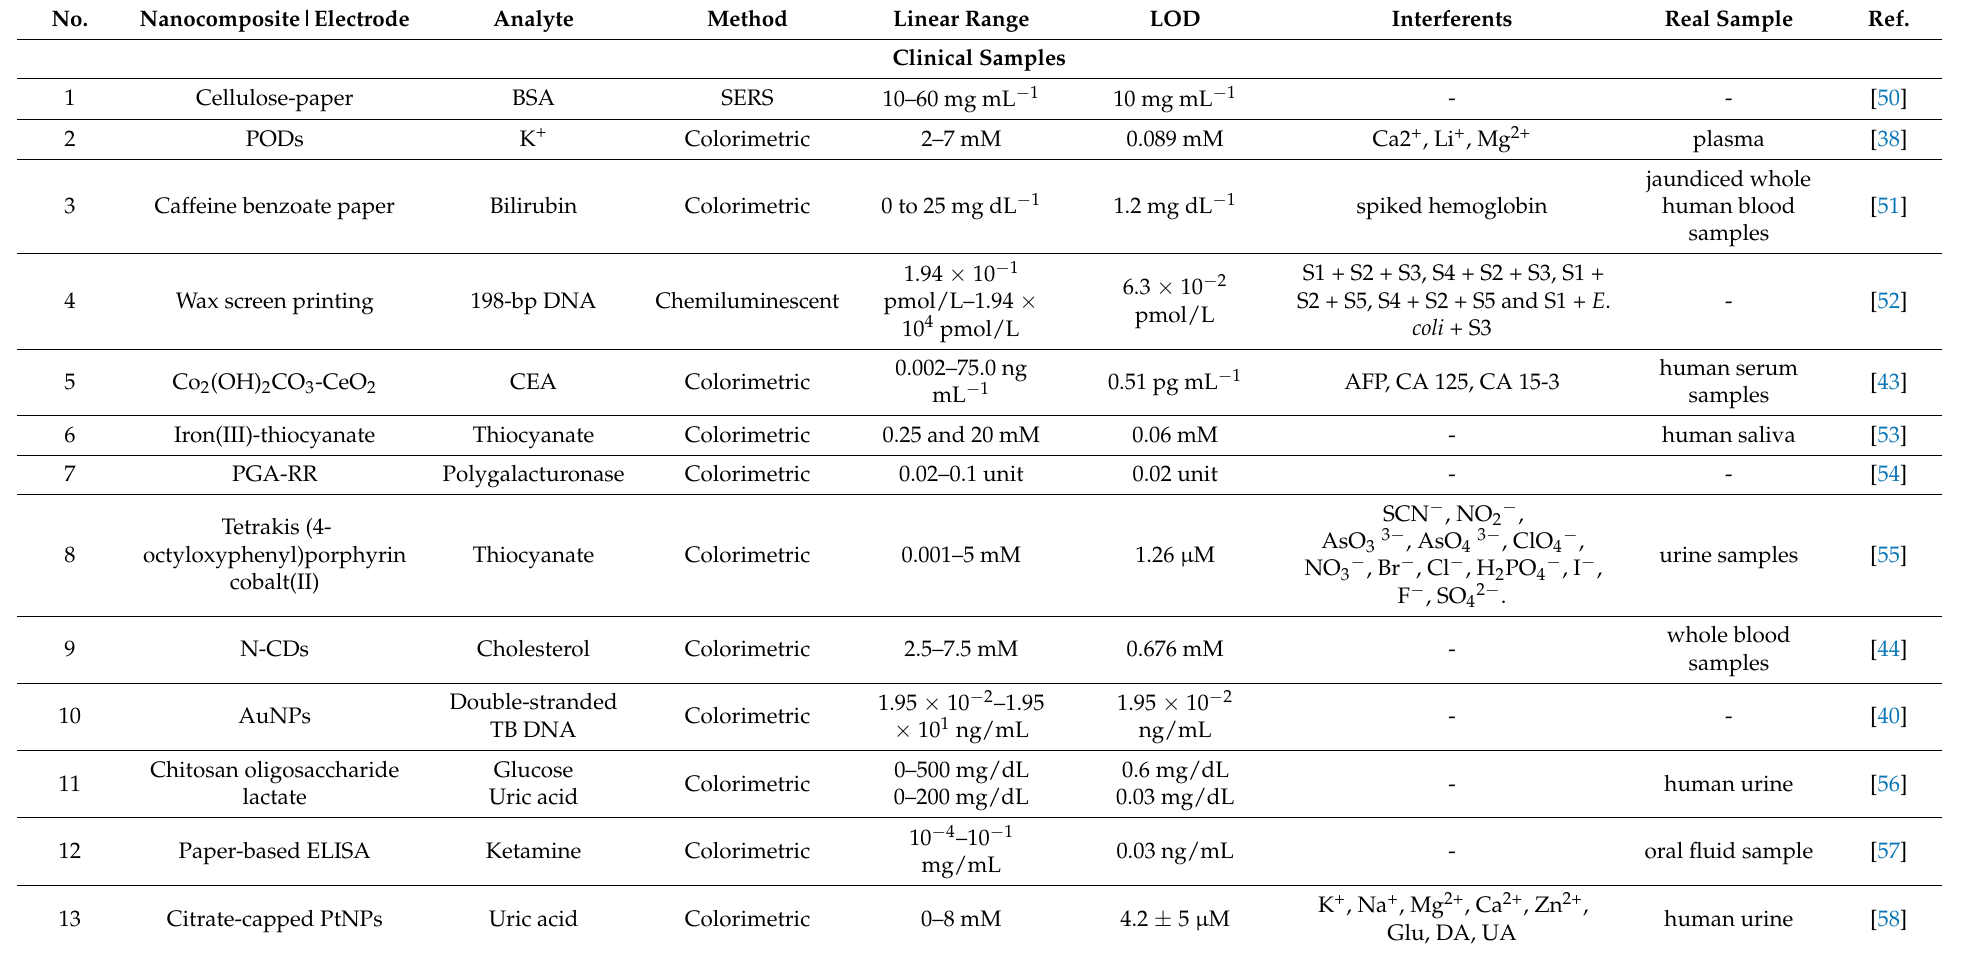
Table 1. Paper-based optical sensors for clinical and environmental